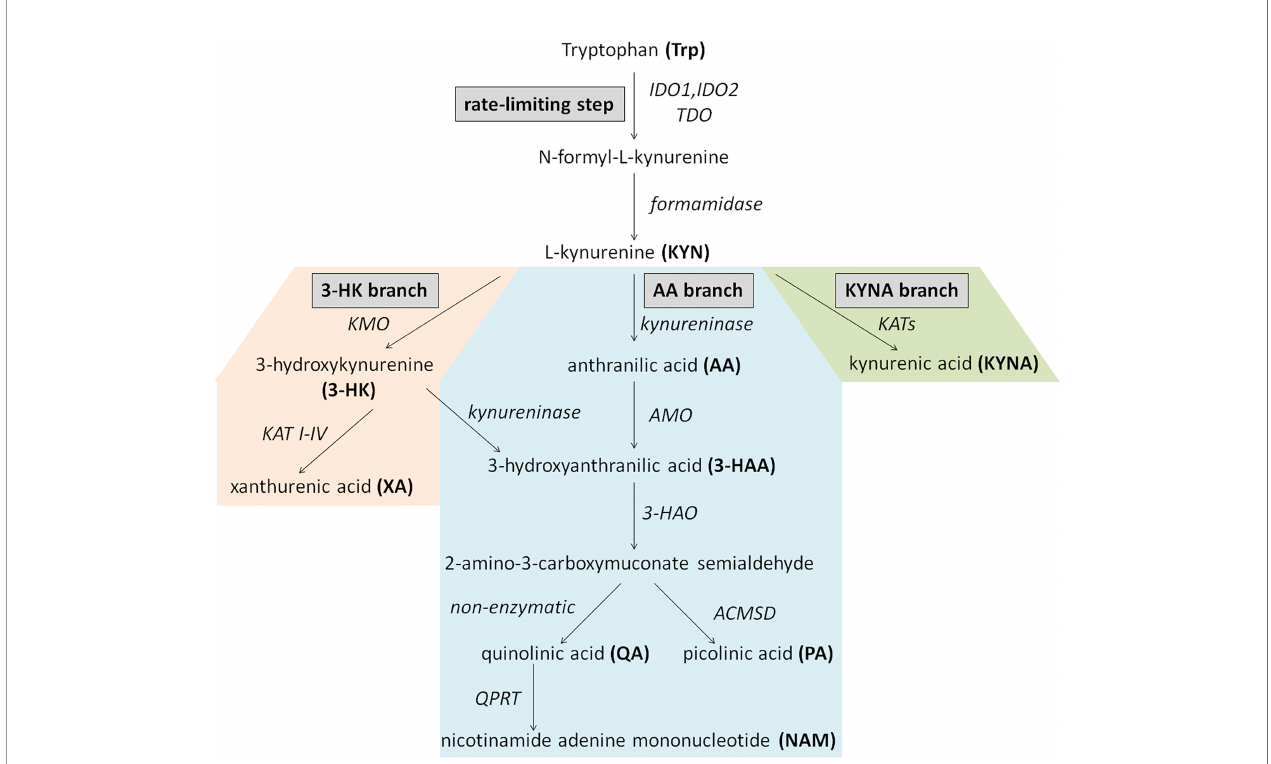
FIGURE 1 | Schematic overview of the kynurenine pathway. Enzymes are indicated in italics. AA, anthranilic acid; ACMSD, aminocarboxymuconate-semialdehyde- decarboxylase; AMO, anthranilate 3-monooxygenase; 3-HAA, 3-hydroxyanthranilic acid; 3-HAO, 3-hydroxyanthranilate 3,4-dioxygenase; 3-HK, 3-hydroxykynurenine; IDO1 and or, IDO2, indoleamine 2,3-dioxygenase-1 and -2; KATs, kynurenine aminotransferase enzymes; KMO, kynurenine monooxygenase; KYN, kynurenine; KYNA, kynurenic acid; NAM, nicotinamide adenine mononucleotide; PA, picolinic acid; QA, quinolinic acid; QPRT, quinolinate phosphoribosyltransferase; TDO, tryptophan-2,3-dioxygenase; Trp, Tryptophan; XA, xanthurenic